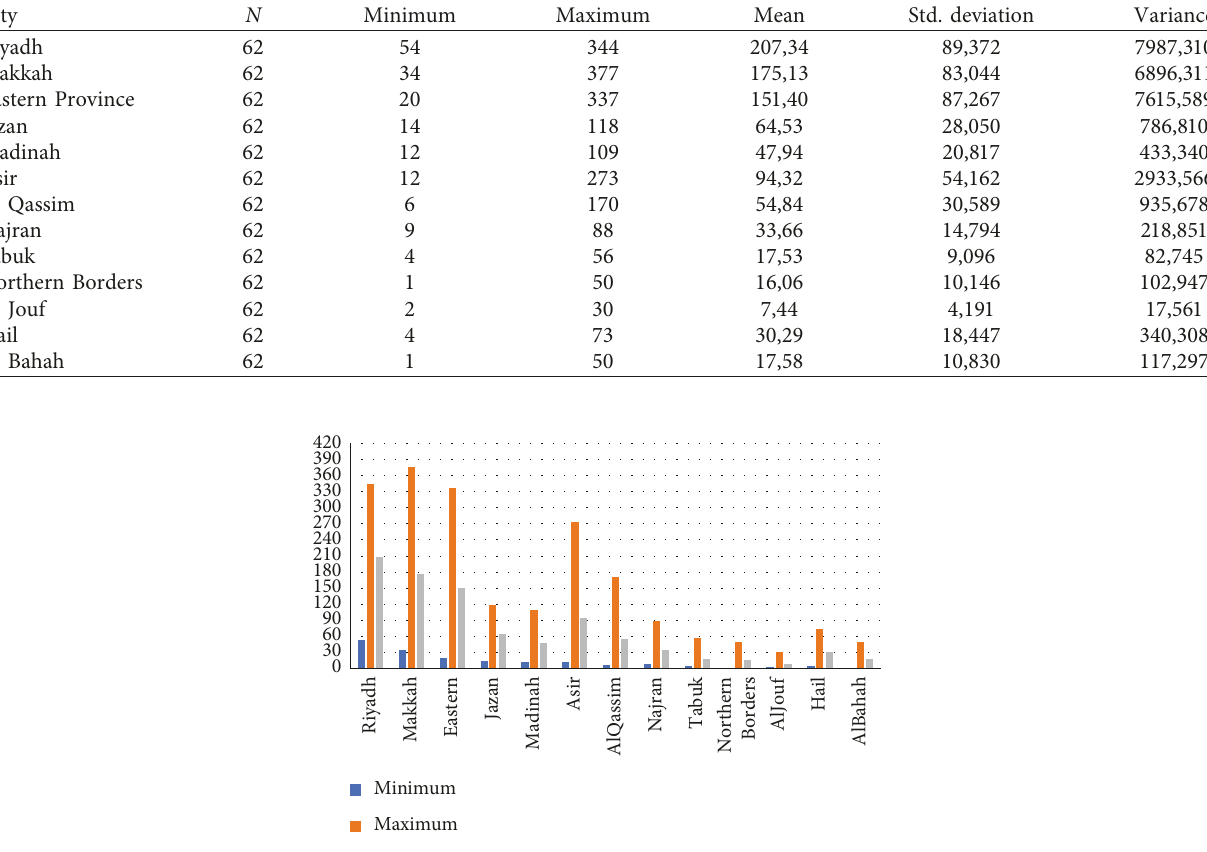
Table 1: Descriptive statistics of coronavirus infections during the specified period.